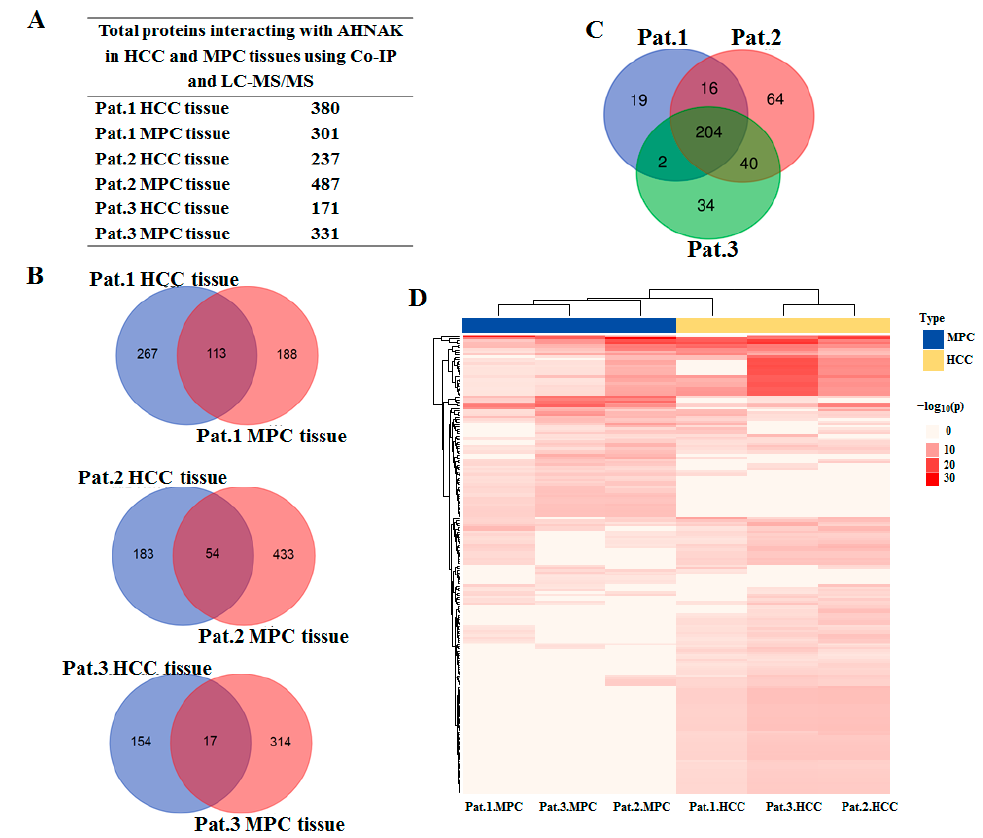
Figure 3. AHNAK involving pathways identified using LC-MS/MS: ( A ) Total proteins interacting with AHNAK in HCC and MPC tissues using Co-IP and LC-MS/MS. ( B ) Venn diagram graphic showing common and specific protein interaction with AHNAK between HCC and MPC tissues from Pat.1, Pat.2 and Pat.3. ( C ) Venn diagram graphics showing 204 enriched pathways shared by all three HCC patients ( p < 0.001). ( D ) Heatmap showing the 204 enrichment pathways in HCC and MPC tissues. The discrete red scale represents statistical significance, and gray indicates a lack of significance. LC-MS/MS, liquid chromatography coupled with tandem mass spectrometry; Co-IP, co-immunoprecipitation; MPC, matched paracancerous.